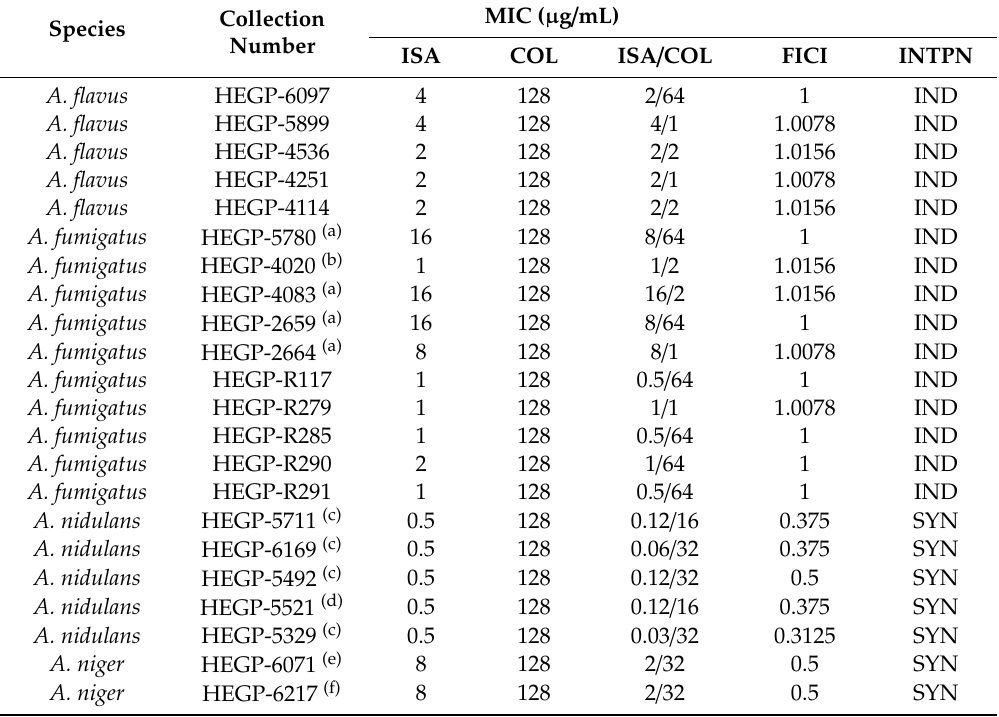
Table 1. In vitro screening of isavuconazole in combination with colistin against Aspergillus species using EUCAST broth microdilution checkerboard